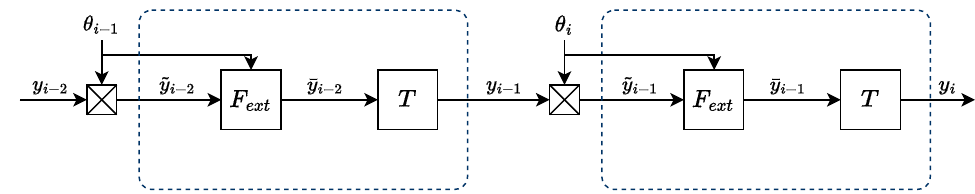
Figure 8. Overview of the compensation strategy scheme using linear extrapolation ( F ext ).